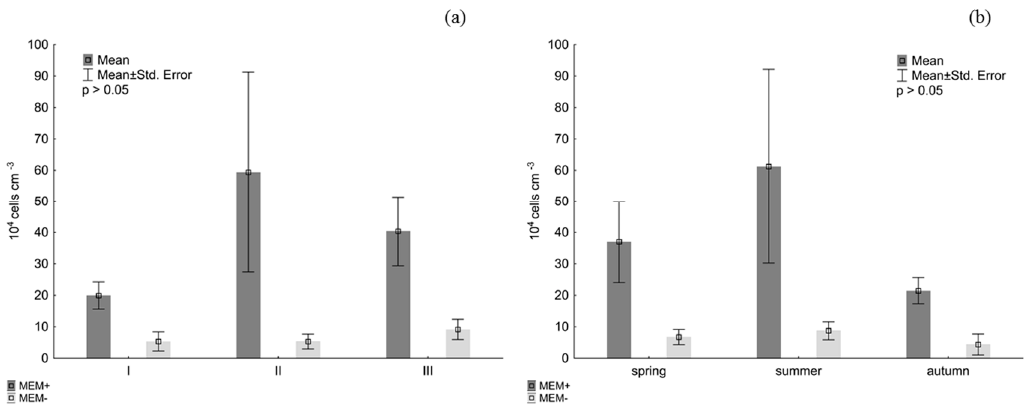
Figure 4. Total abundance of planktonic bacteria with the integral cell membrane (MEM+) and damaged cell membrane (MEM ‐ ) ( a ) at the research sites, ( b ) in the research seasons.